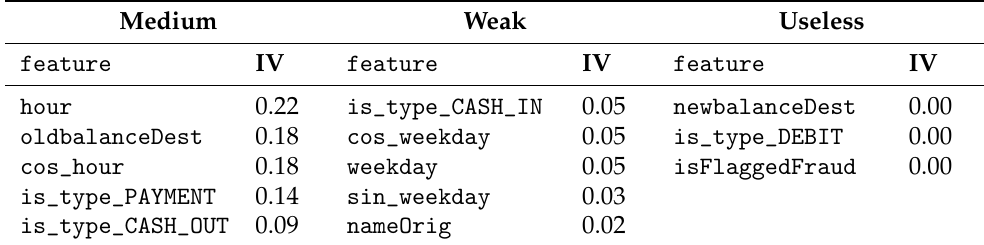
Table 14. Extended PaySim dataset information value—part 2.